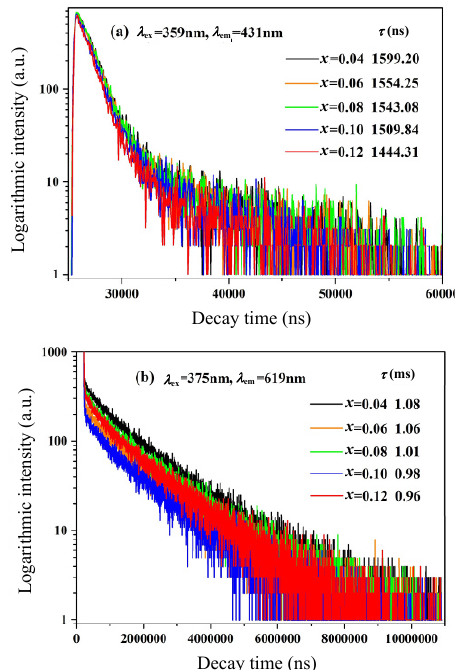
Fig. 7 Decay curves of Ba 0.79 Al 10.9 O 17.14 : x Eu ( x = 0.04–0.12) monitored at (a) 431 and (b) 619